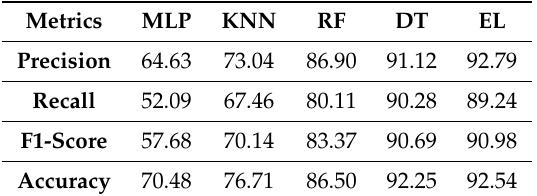
Table 3. Average cross validation score of each model (10-min prediction validity with a 60% threshold).